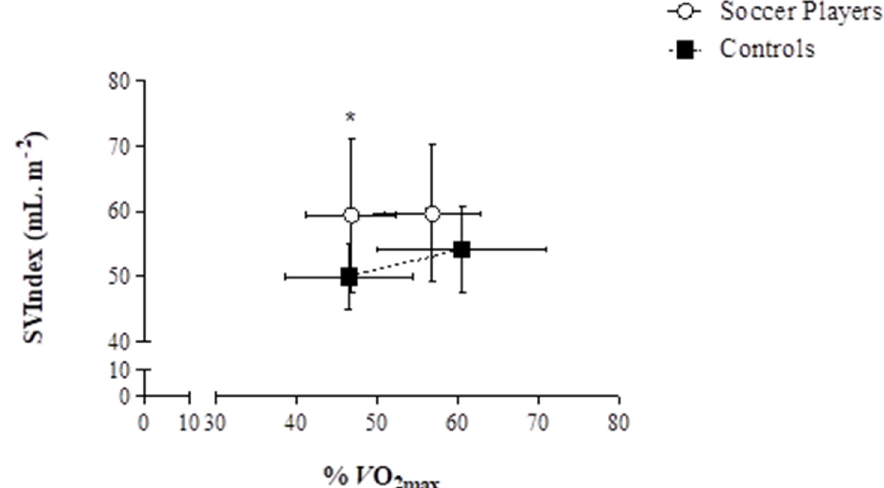
Figure 3. SVIndex responses of soccer players ( n = 22) and controls ( n = 15) at the two comparable, relative exercise intensities (RE (1) and RE (2)). The symbols denote the mean values. Horizontal error bars denote the variability (SD) in relative exercise intensity (%VO 2 max) and vertical error bars denote the variability (SD) in SVIndex. At RE (1), the SP demonstrated significantly greater SVIndex responses than the CON. There was no significant inter-group difference in SVIndex at RE (2). * denotes p ≤ 0.05. Unnithan et al., [33]. Reprinted with permission from Unnithan et al., [33], 2018, John Wiley and Sons.